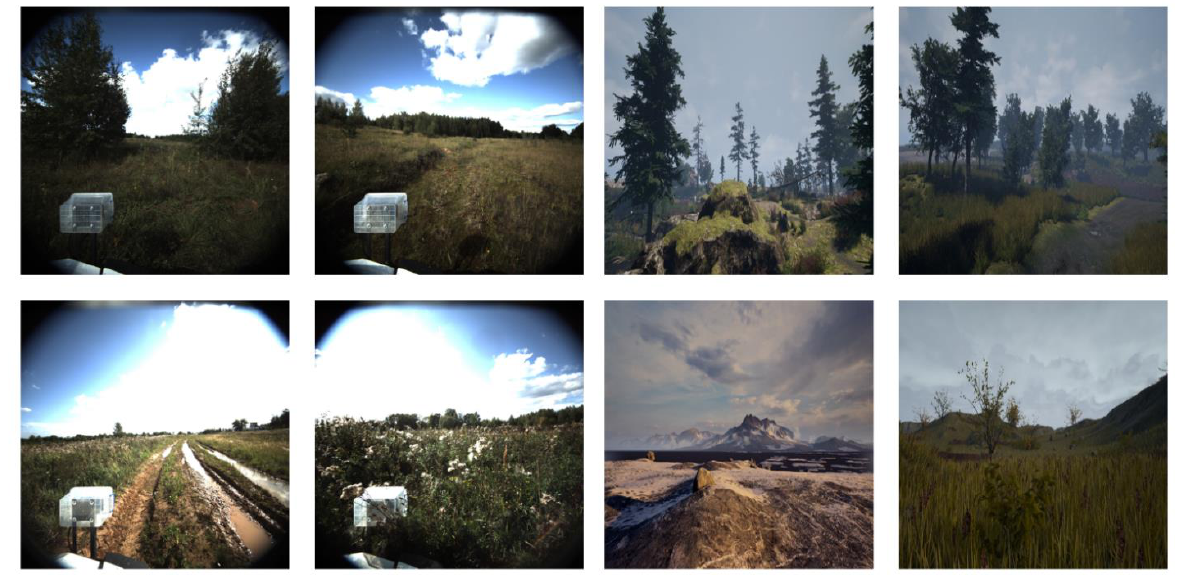
Figure 1. Sample images from our off-road